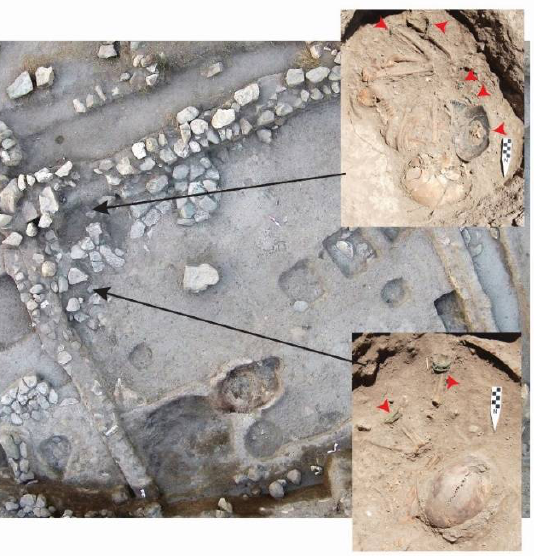
Figure 15. Photos of the stone pavement in the southeastern corner of the Omphalos Building courtyard showing the three spaces (where pavement stones were removed) created for the insertion of the infant/child burials; two of the burials (top, F161; bottom, F162) shown with red arrows indicating burial gifts (copper jewelry, ceramics).